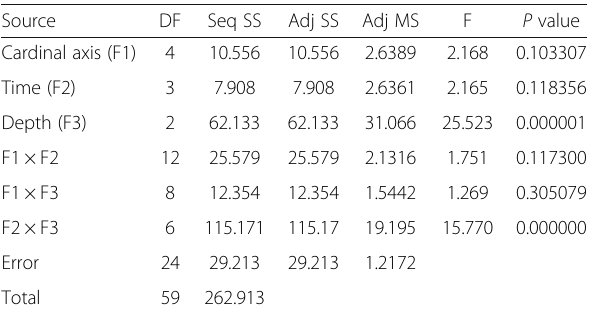
Table 7 Three-way analysis of variance to test the between-subjects effects on PXD residue in soil